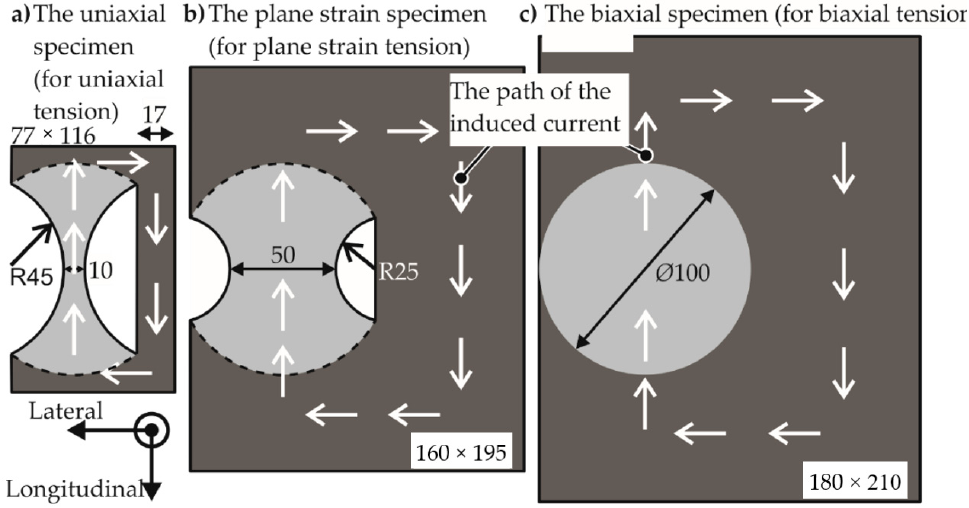
Figure 5. The three specimen shapes of the electromagnetic forming limit test. The brighter shade represents the deforming region. The darker shade acts as a return path for the induced current to close itself. Dimensions in mm.